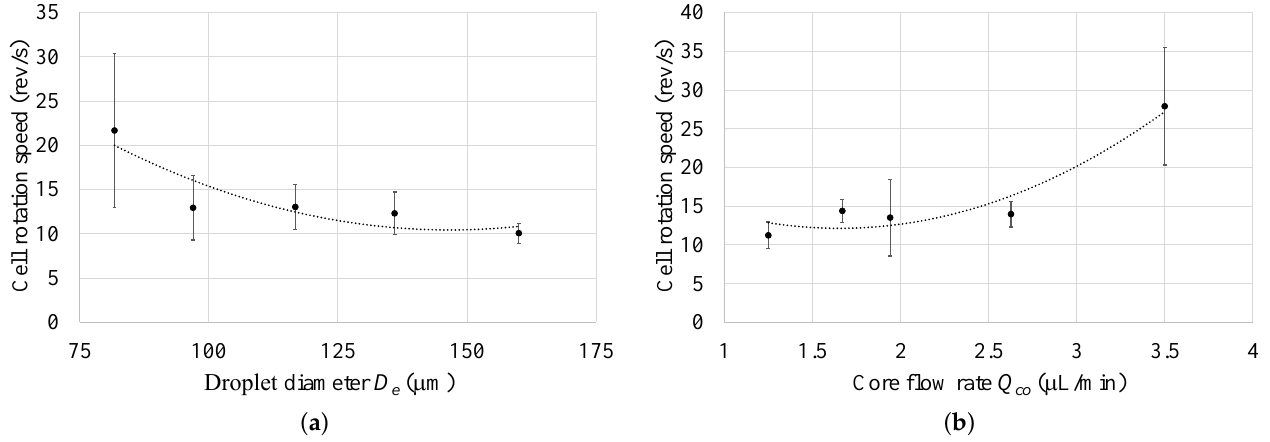
Figure 11. Cell rotational speed ( Ω ) after sheath flow at different values of: ( a ) droplet diameter D e , and ( b ) core flow rate Q co